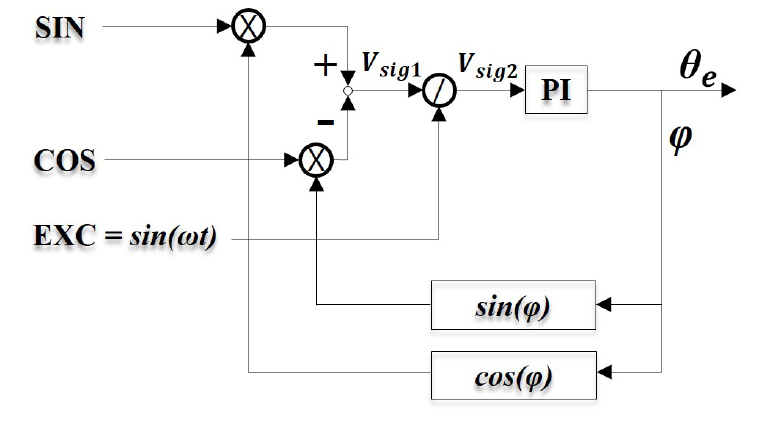
Figure 3. ATO algorithm block